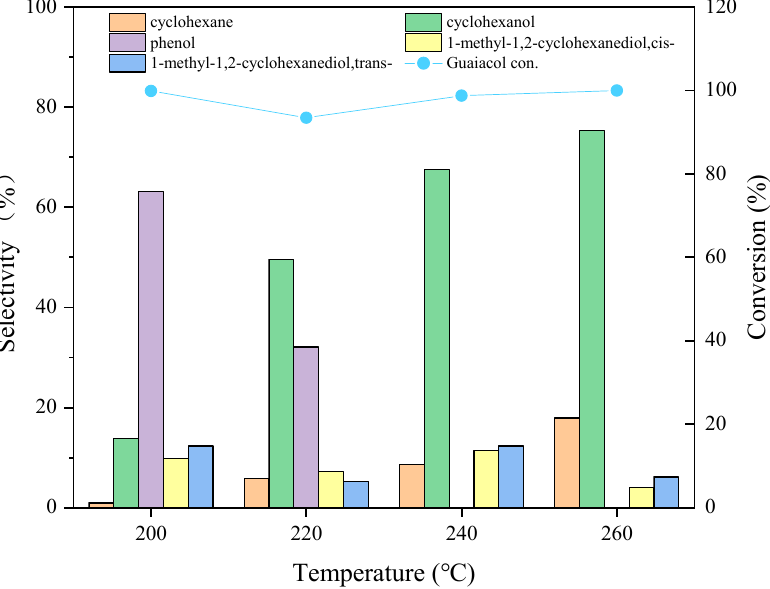
Figure 5. Guaiacol conversion and product distribution at different temperatures. Reaction conditions: Ni3Mo1@C catalyst, p = 2 MPa, and t = 4 h.